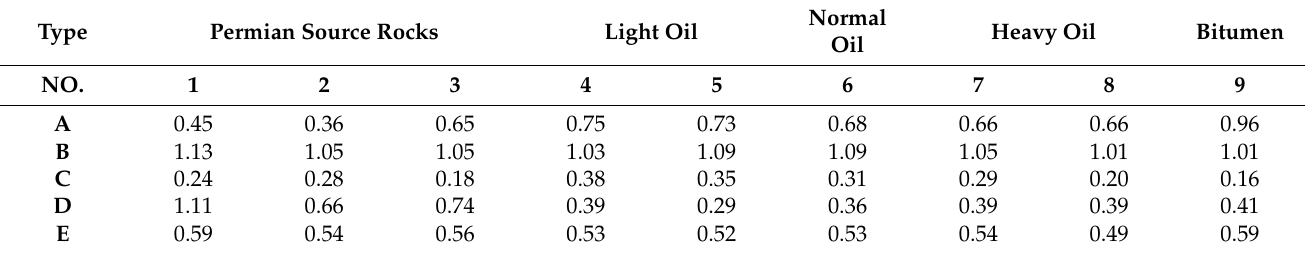
Table 3. Biomarker parameters of source rocks and crude oil samples in Wuerhe